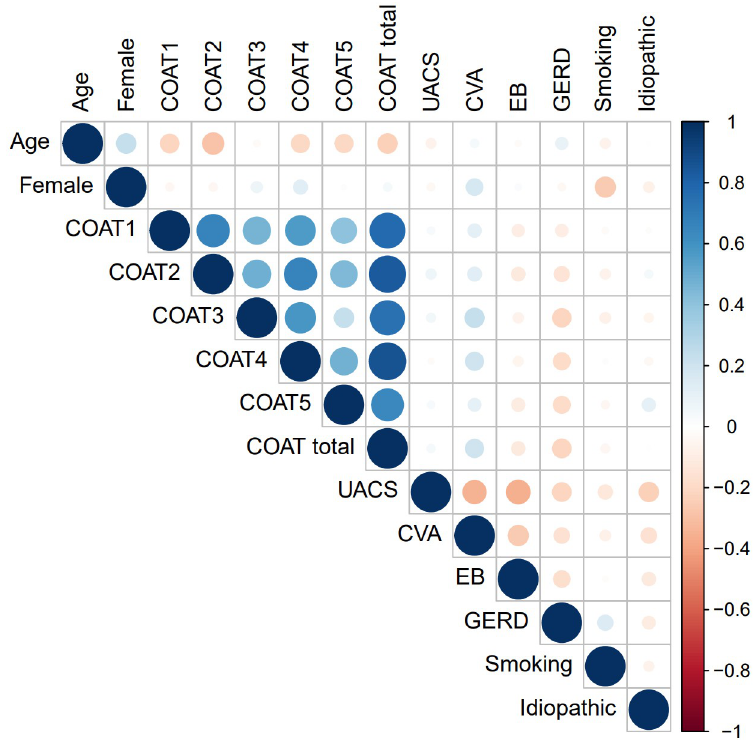
Fig 1. Correlation matrix for COAT score and aetiologies of chronic cough. Pearson’s correlation between variables was performed. The intensity of the colour correlates with the strength of the association. Blue indicates positive correlation and red indicates negative correlation. COAT 1: frequency of cough, COAT 2: limitation of daily activities, COAT 3: sleep disturbance, COAT 4: fatigue, COAT 5: hypersensitivity to irritants.